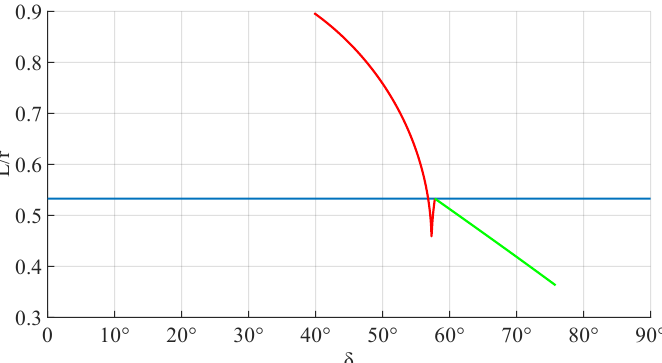
Figure 9. Contact distance under transformable state C 1 and C 2 L / r (10 mm) (Blue: wheel state; Red: